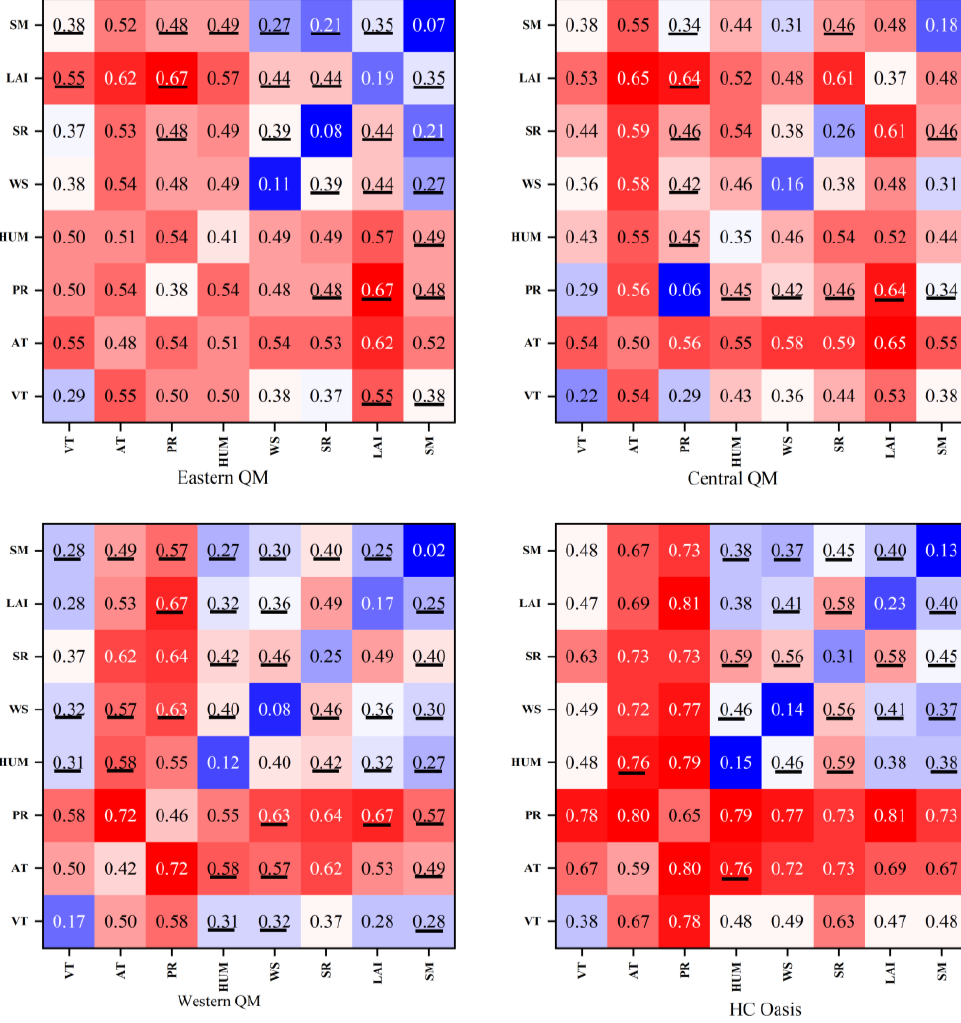
Figure 13. The explanatory power of interaction between factors for spatial stratified heterogeneity of the study area. The underlined numbers in the figure show that the interaction of the two factors is non-linearly enhanced, and the numbers with no underline suggest that the interaction of the two factors is mutually enhanced.